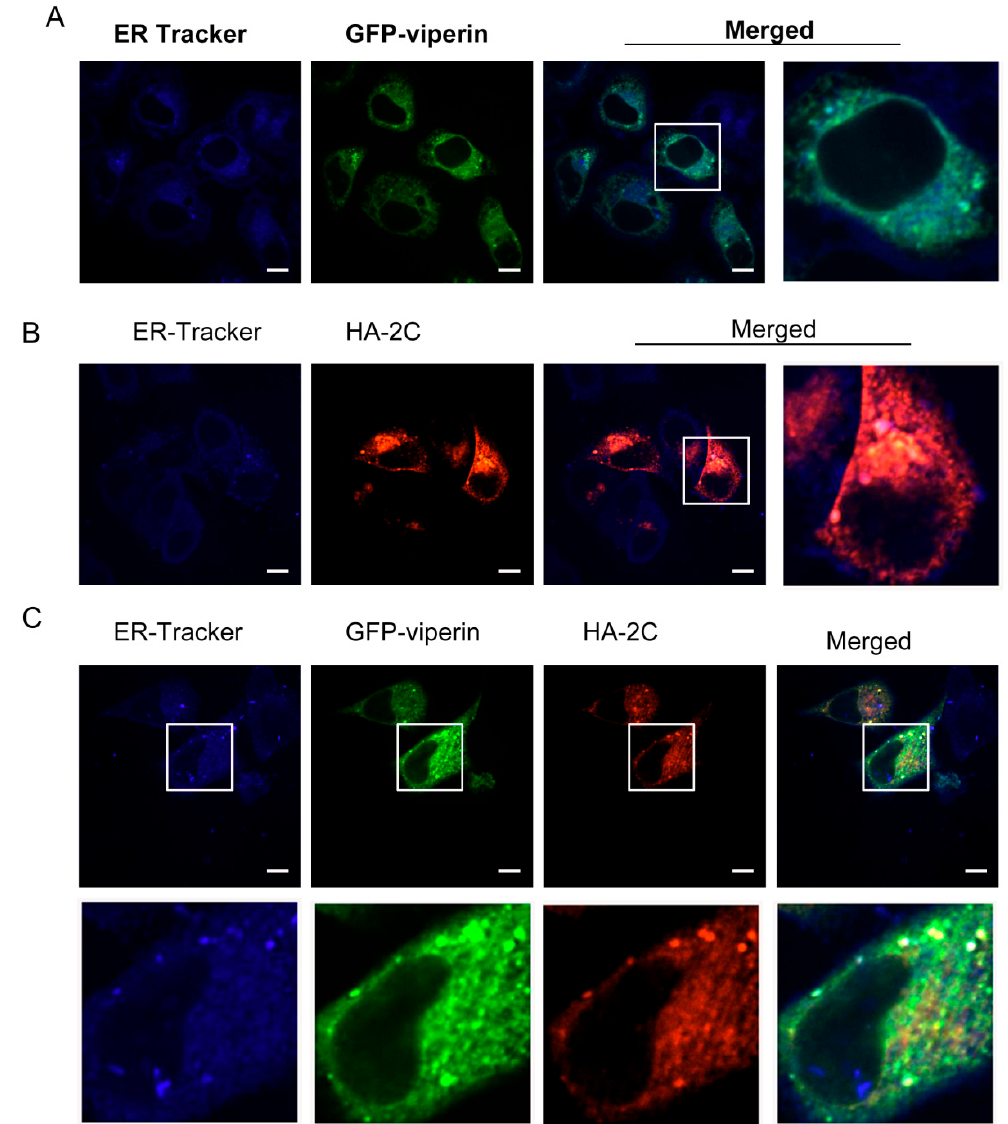
Figure 4. Viperin colocalization with EVA71 2C in the endoplasmic reticulum (ER). 293T cells were transfected with ( A ) GFP-viperin, ( B ) HA-2C, or ( C ) co-transfected with HA-2C and GFP-viperin for 24 h. The cells were fixed and stained with ER-Tracker Blue-White for ER labeling and then visualized under a fluorescent microscope. In the above experiments, viperin (green) and HA-2C (red) are shown, as well as ER (blue) counterstained with ER-Tracker. The enlarged images corresponding to the rectangle areas are shown next to (A and B) or below (C). Scale bar is 10 µ